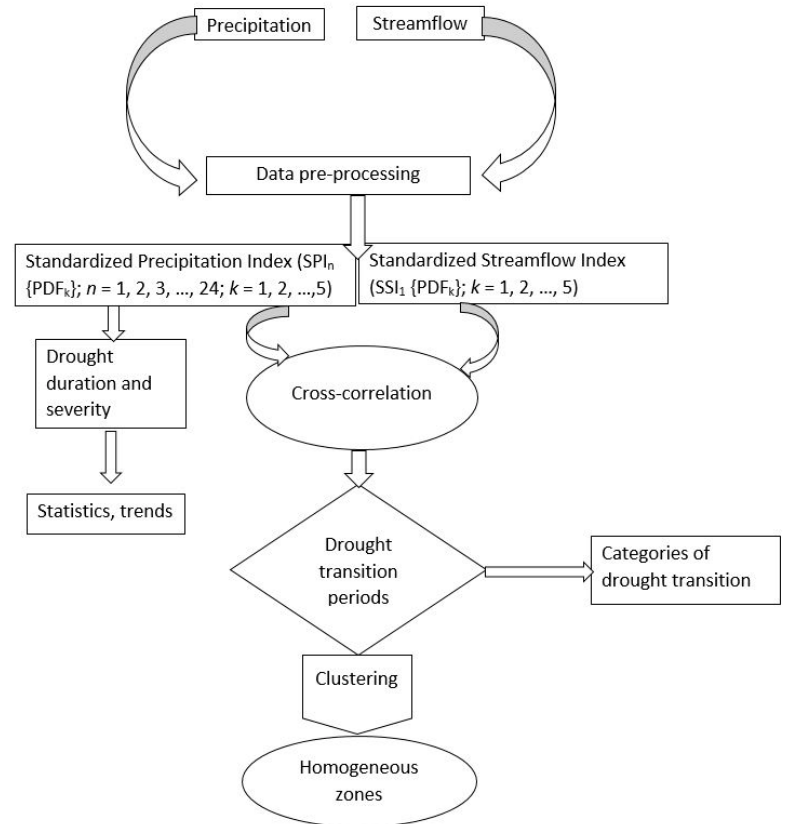
Figure 3. The schema used for drought characterization across South Africa. A total of k (i.e., k = 1, 2, ..., 5) probability distribution functions (PDF) comprised of the two- and three-parameter probability distributions were considered.